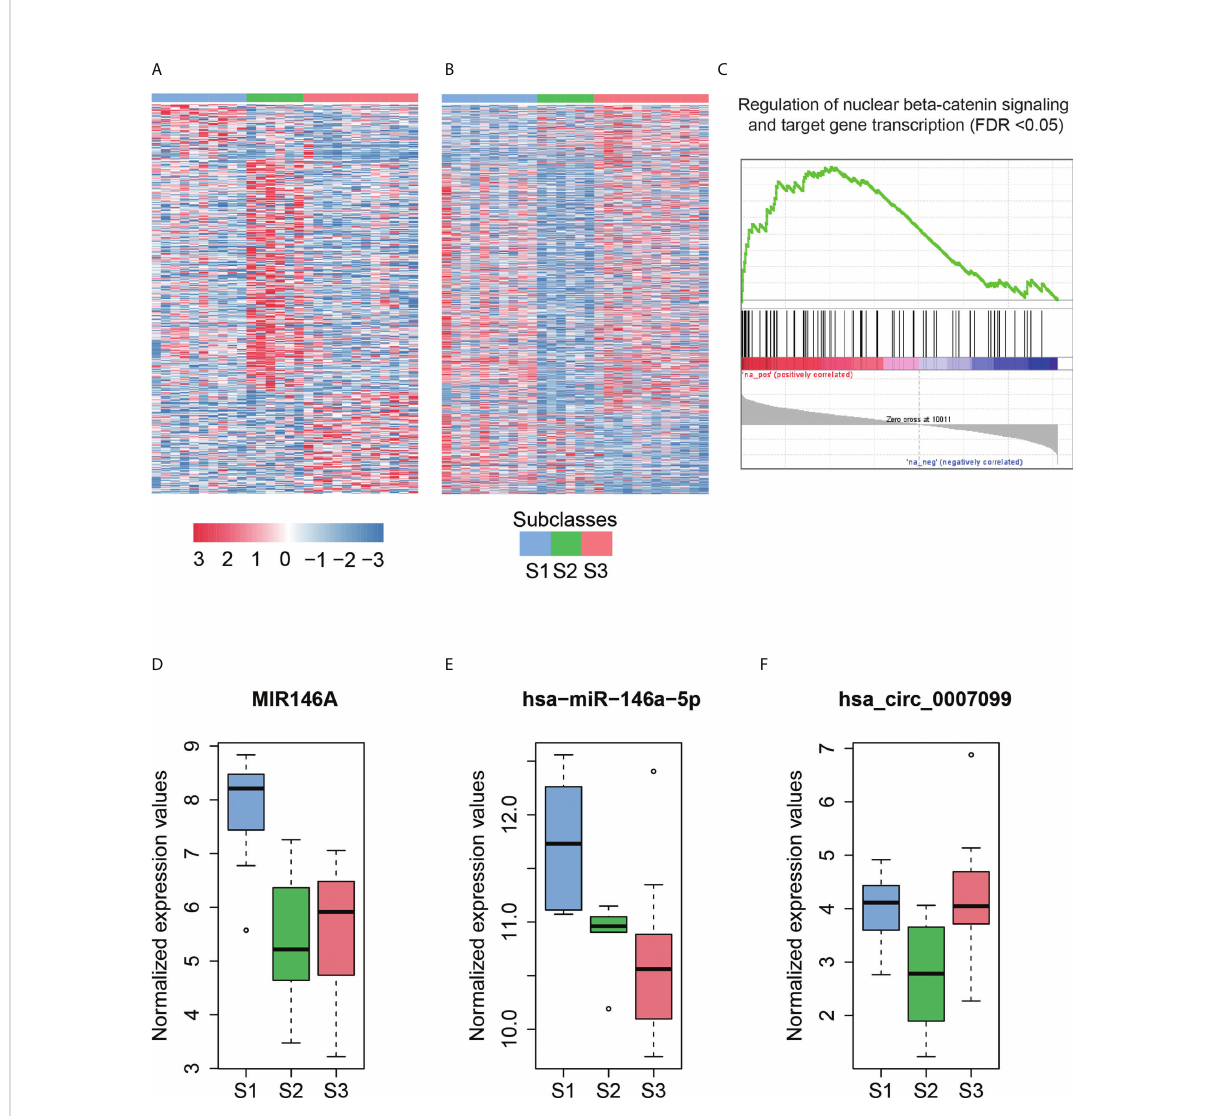
FIGURE 4 The subclass-associated dysregulated ncRNAs in HCC. The upregulated (A) and downregulated (B) ncRNAs in Hoshida subclasses. (C) Co- expression-based GSEA for DLX6-AS1. The highly correlated genes with DLX6-AS1 are signi fi cantly enriched in the gene set from regulation of nuclear beta-catenin signaling and target gene transcription. The expression patterns of MIR146A (D) and hsa-miR-146a-5p (E) in Hoshida subclasses. The miRNA host gene, MIR146A, and its derived miRNA, hsa-miR-146a-5p, are upregulated in the S1 subclass. (F) The hsa_circ_0007099 is downregulated in the S2